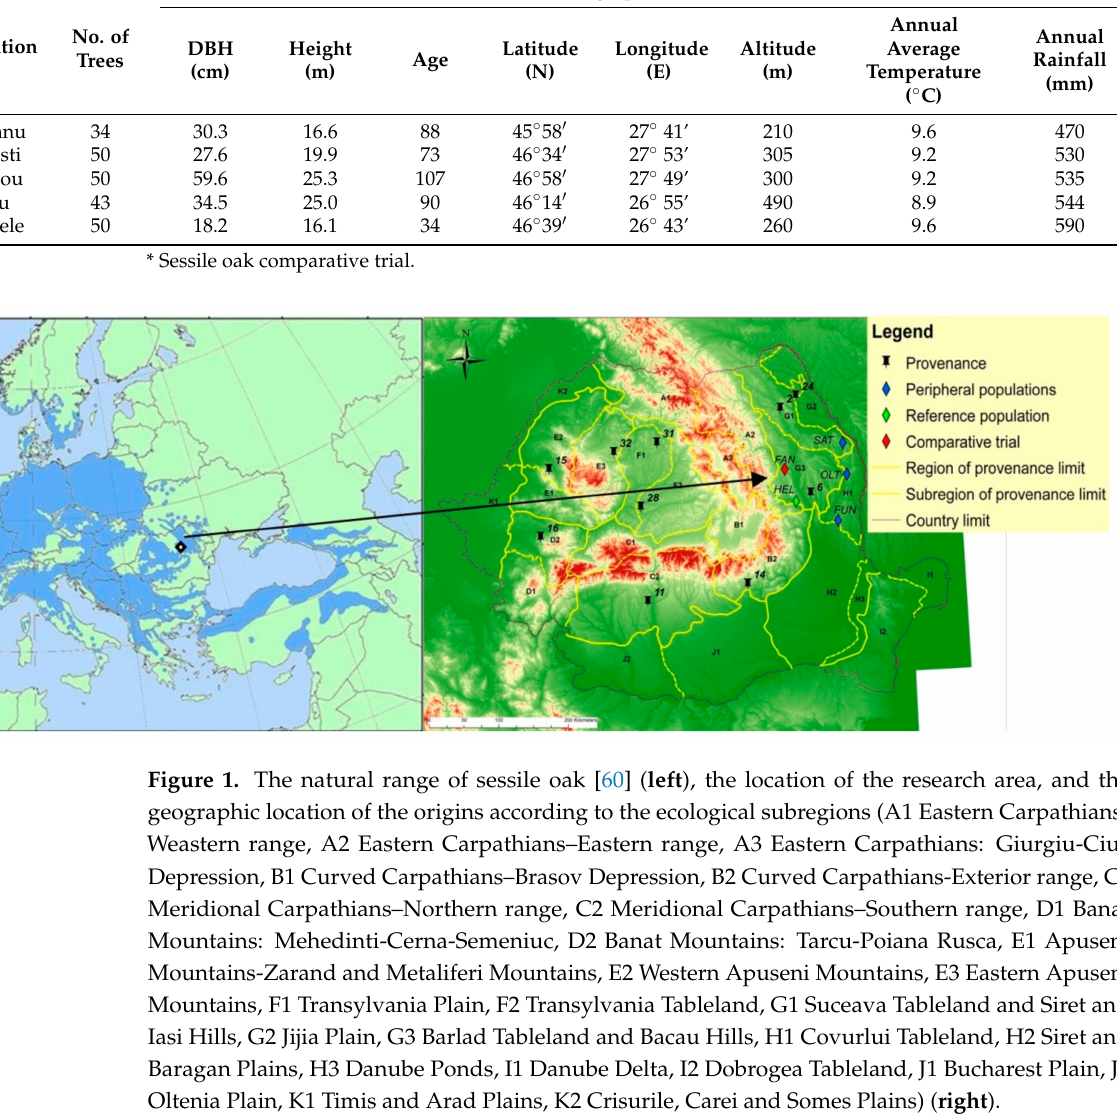
Oltenia Plain, K1 Timis and Arad Plains, K2 Crisurile, Carei and Somes Plains) ( right ). A total of 227 mature individuals were identified and phenologically evaluated in the four selected populations. For the FAN comparative trial, five trees from each of the ten provenances were selected randomly (Table